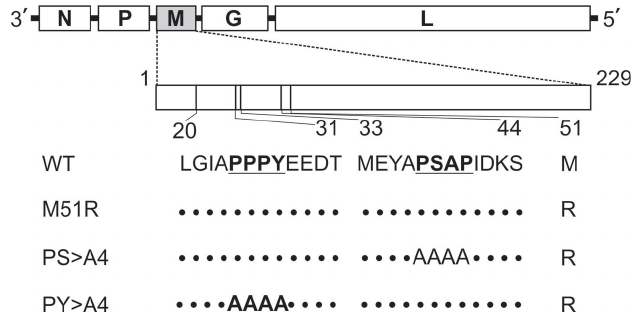
Figure 1. Diagram of the Vesicular stomatitis virus (VSV) genome with the M gene (highlighted in gray) expanded. The amino acid positions and sequences of the PPPY (amino acids 20 to 31) and PSAP (amino acids 33 to 44) regions of M are shown for the indicated viruses. The PPPY and PSAP motifs are shown in bold and underlined. The dotted lines indicate that the VSV-wild type (VSV-WT) M sequence is